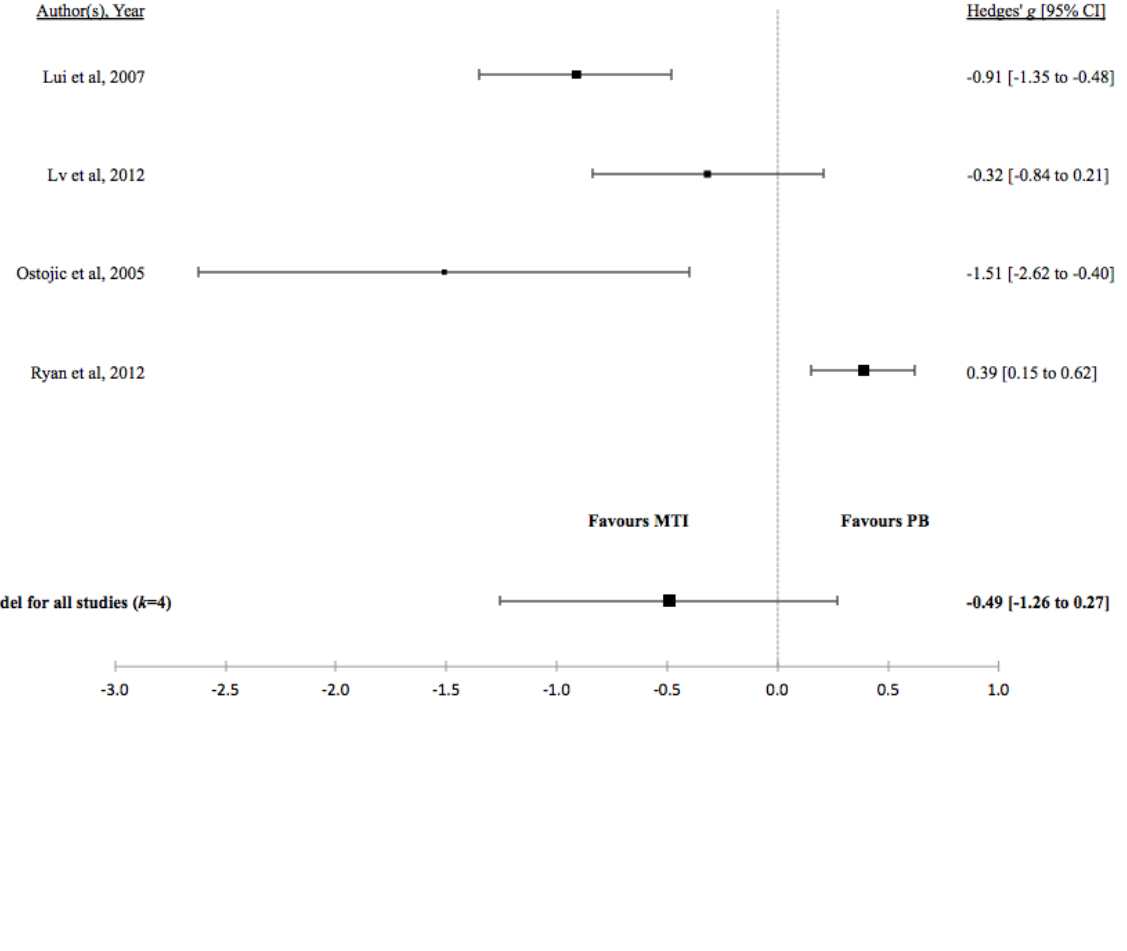
Figure 10. Forest plot of the standardized mean difference in unscheduled visits between MTI and paper-based group. MTI: mobile technology